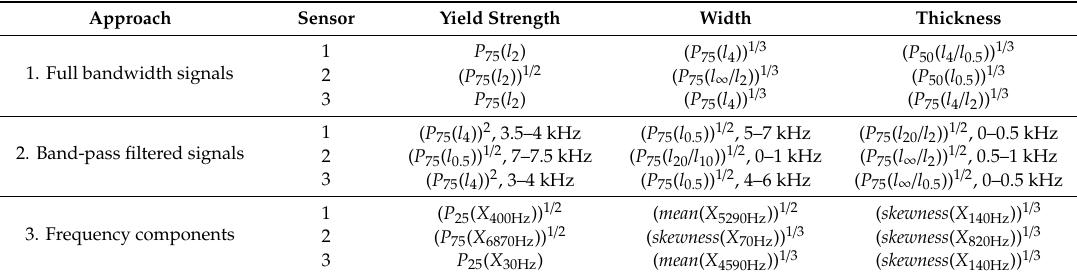
Table 5. Features with strongest correlations to steel strip properties. P k stands for the k th percentile and X j stands for the amplitude of frequency j